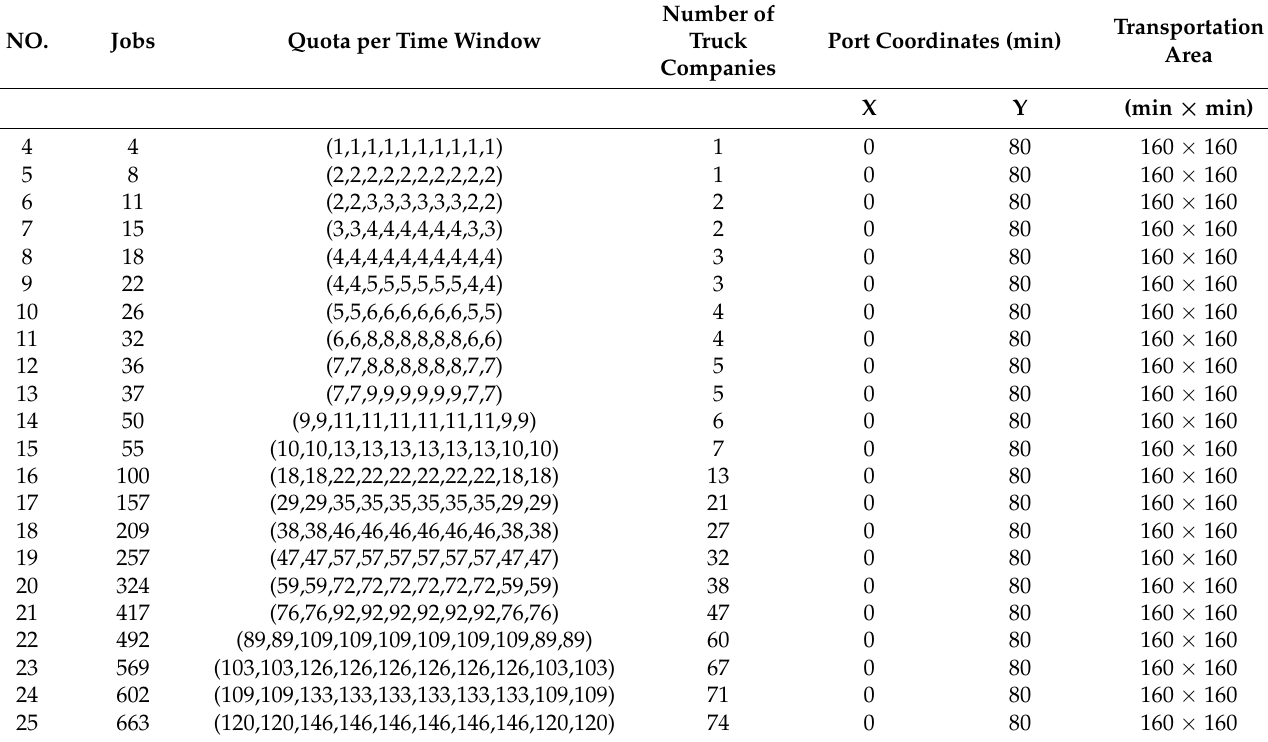
Table A1. Parameter data in